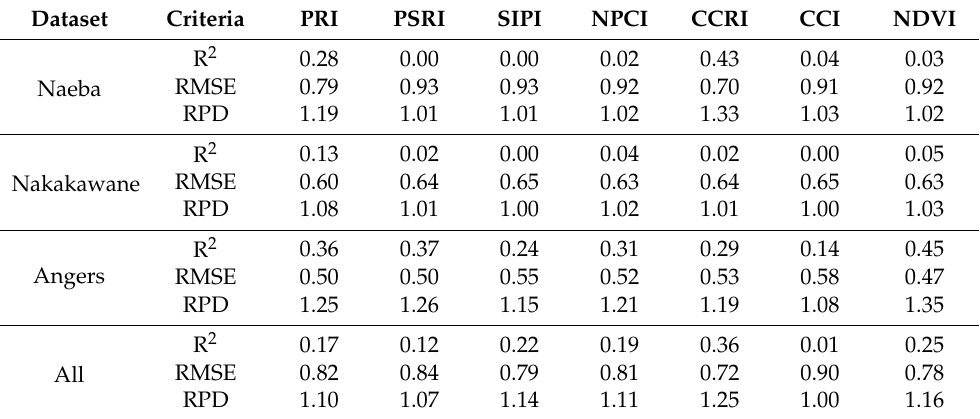
Table 3. Performance of reported indices for the evaluation of the ratio of chlorophyll (Chl) to carotenoid (Car) in the individual and composite